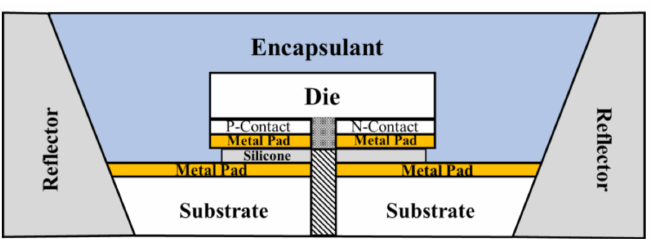
Figure 2. Cross-sectional view of a packaged flip-chip type high-power GaN based die via the NL bonding method.